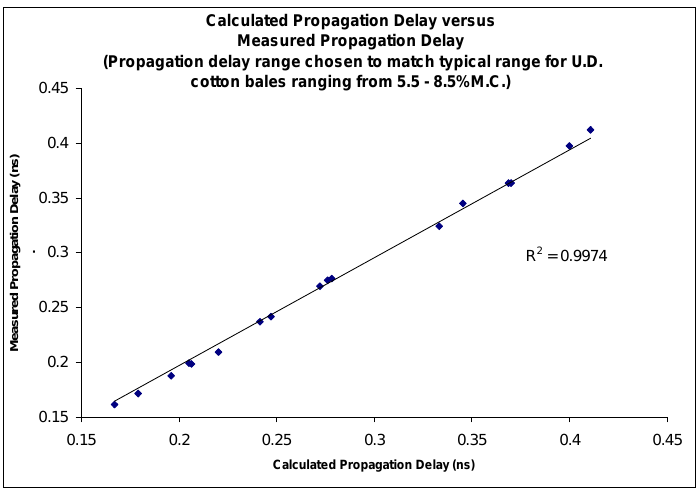
Figure 2. Comparison between permittivity as calculated from the known values versus sensor’s measured